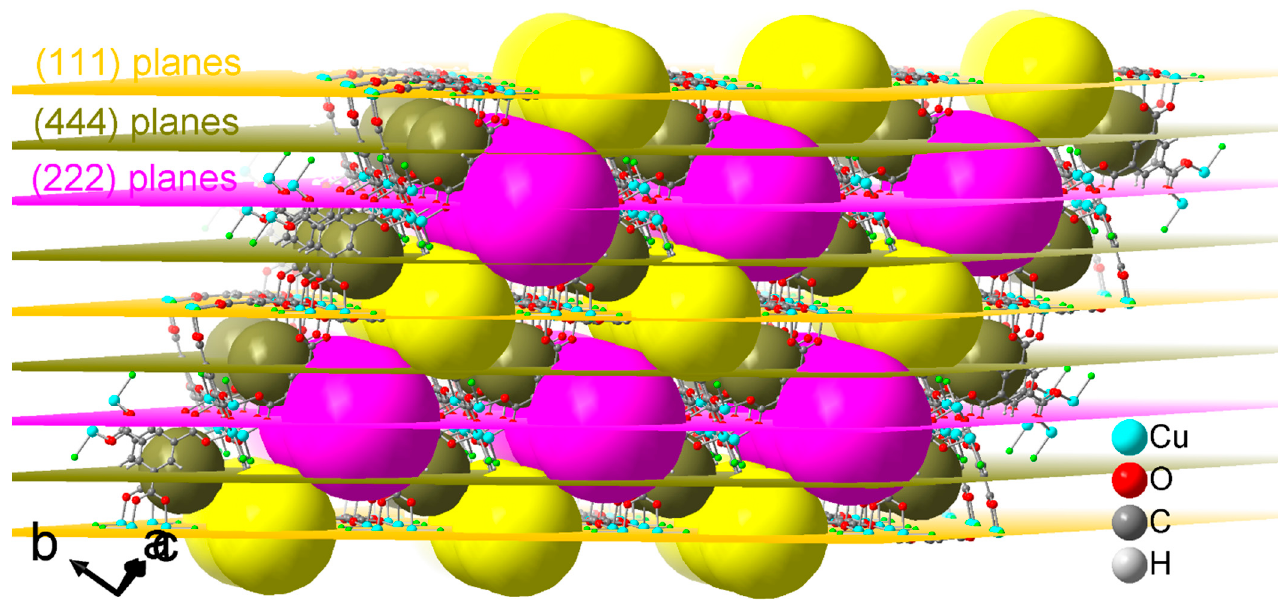
Figure 8. Position of the set of (111), (222) and (444) planes in HKUST-1 (cif file with Refcode FIQCEN (axis a = 26.343(5) Å) [19] from the CCDC). The spacing of the set of (111) planes is 15.2 Å, and the spacing of the set of (222) planes, which also includes the set of (111) planes, is 7.6 Å. The spacing of the set of (444) planes (including (111) and (222) planes) is 3.8 Å. For the description of the different pores see Figure 2a-c and the accompanying text.